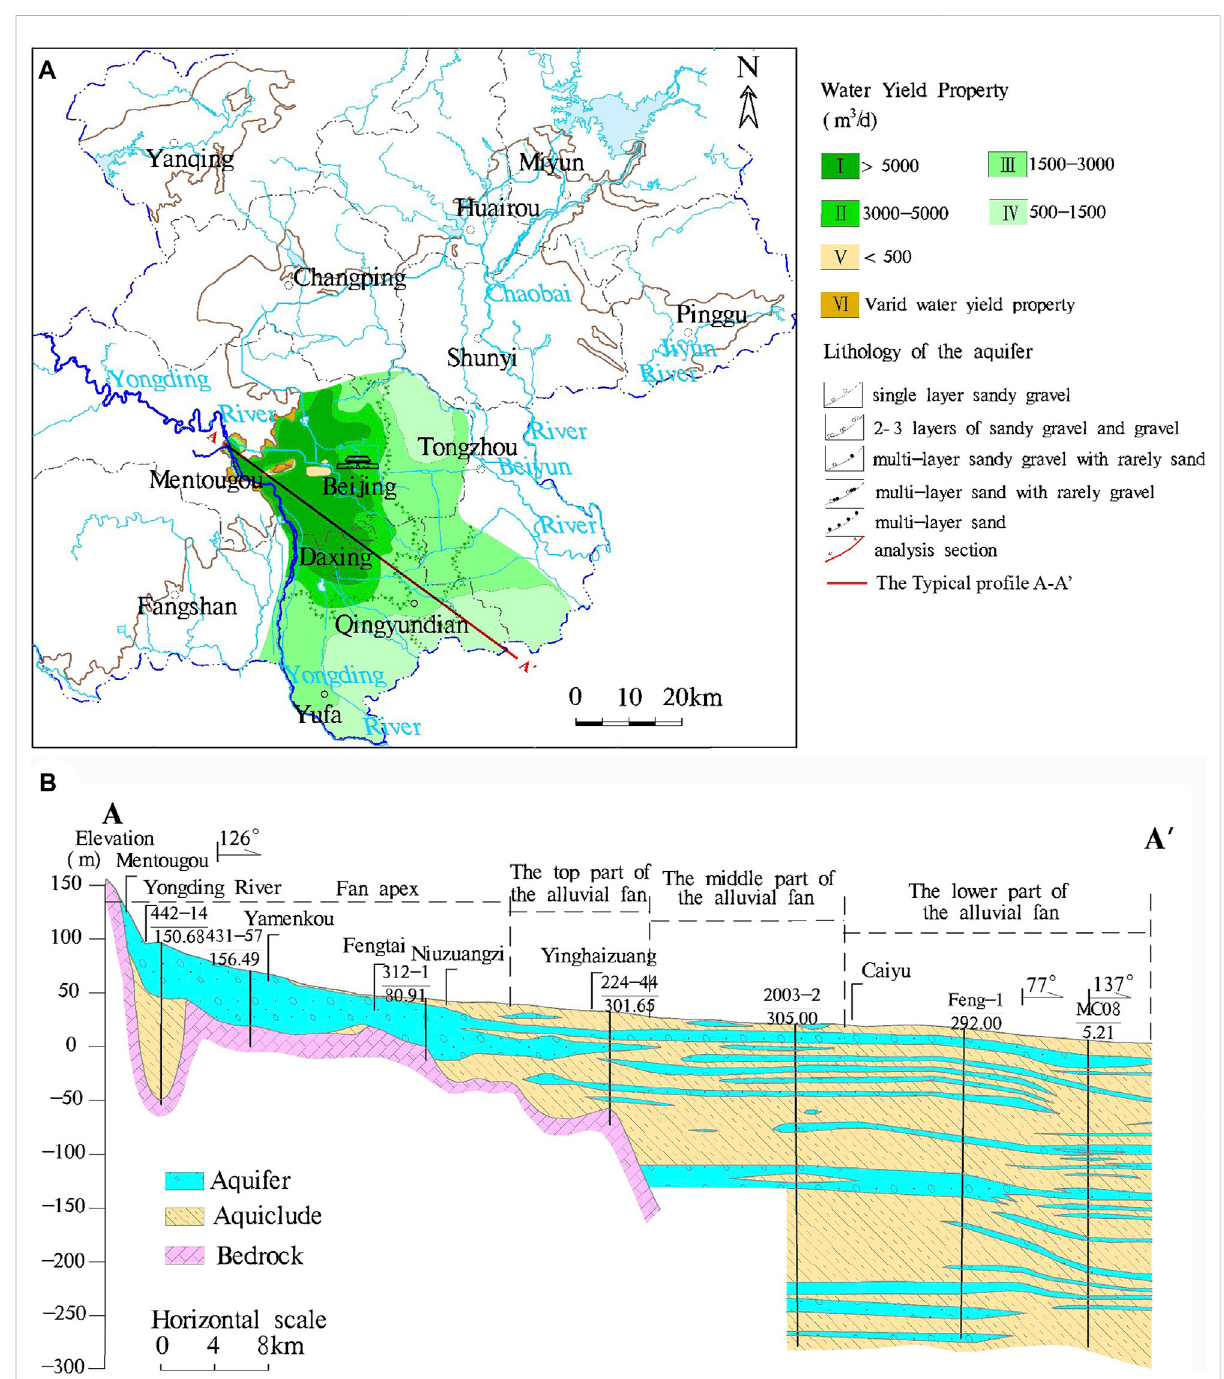
FIGURE 2 (A) Schematic map of groundwater yield property zoning and lithology of the Yongding River groundwater system in Beijing and (B) hydrogeological pro fi le of the Yongding River alluvial